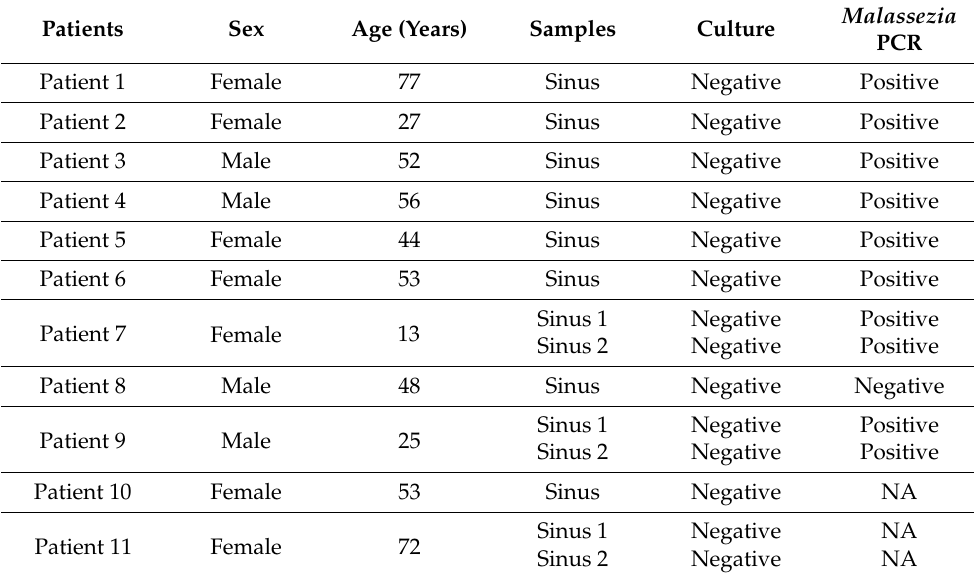
Table 2. Culture and PCR results on sinus